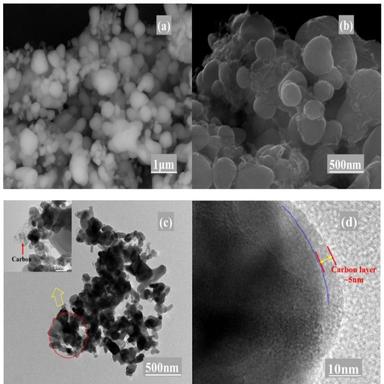
(aeb) FE-SEM and (ced) HR-TEM images of LiMn0.5Fe0.5PO4/C powders.